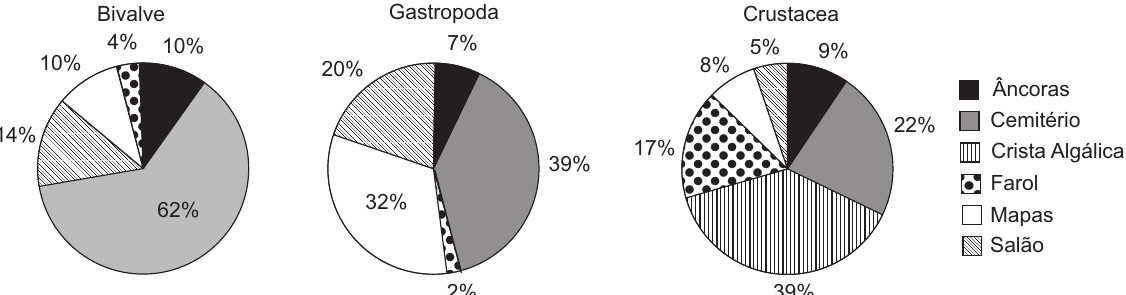
Figure 5. Frequency of occurrences of the food remains (Crustacean, Gastropoda and Bivalve) identified in the dens of Octopus insularis , in relation to the sample areas of Atol das